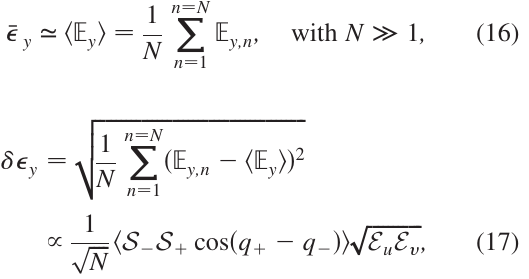
FIG. 2. E (red) from Eq. (5) and (cid:3) y Eq. (14) plotted along the ESRF storage ring, for two different amounts of coupling inferred from ORM measurements. The black triangles indicate the positions where E mate the average projected emittance (cid:2) (cid:3) would be instead underestimated by measurements at the blue